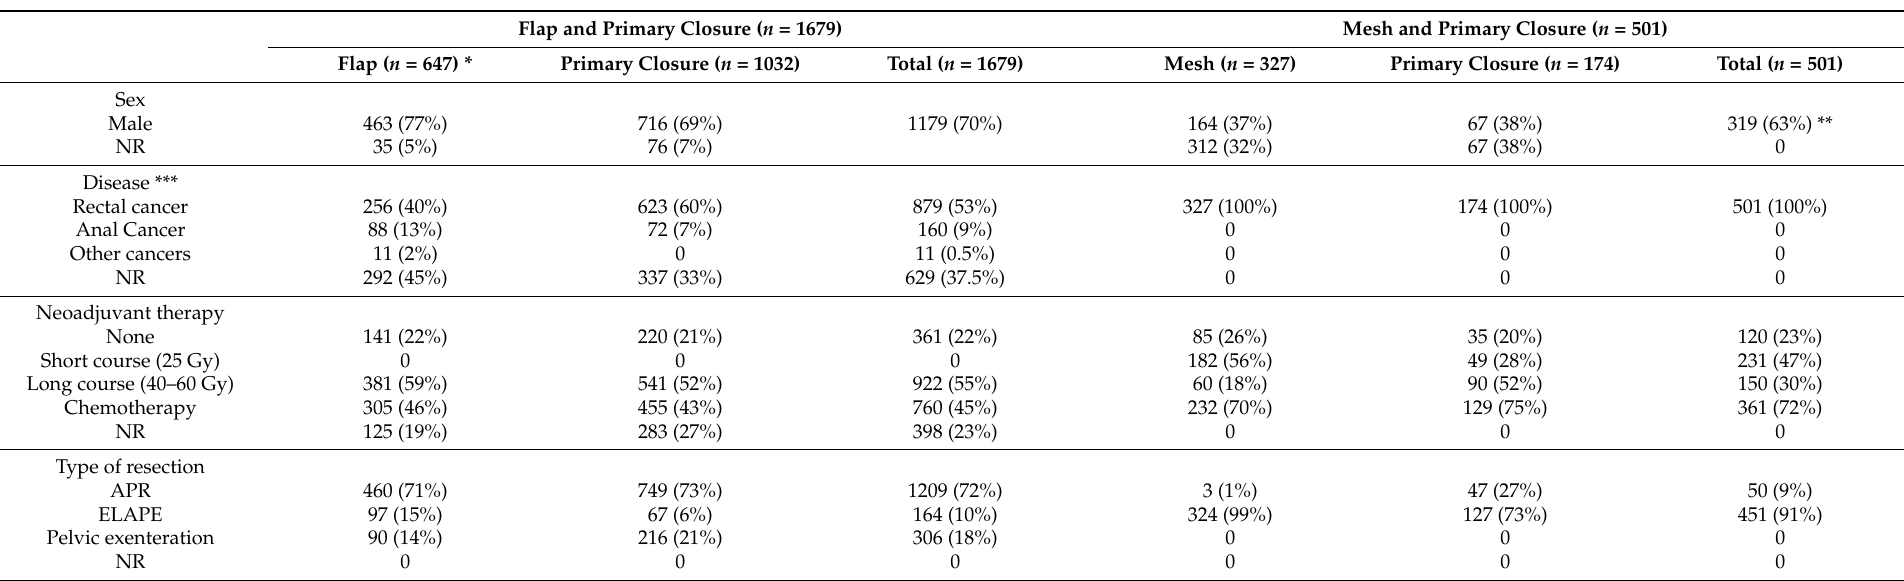
Table 2. Pooled baseline characteristics of study population with flap closure and primary closure; mesh closure and primary